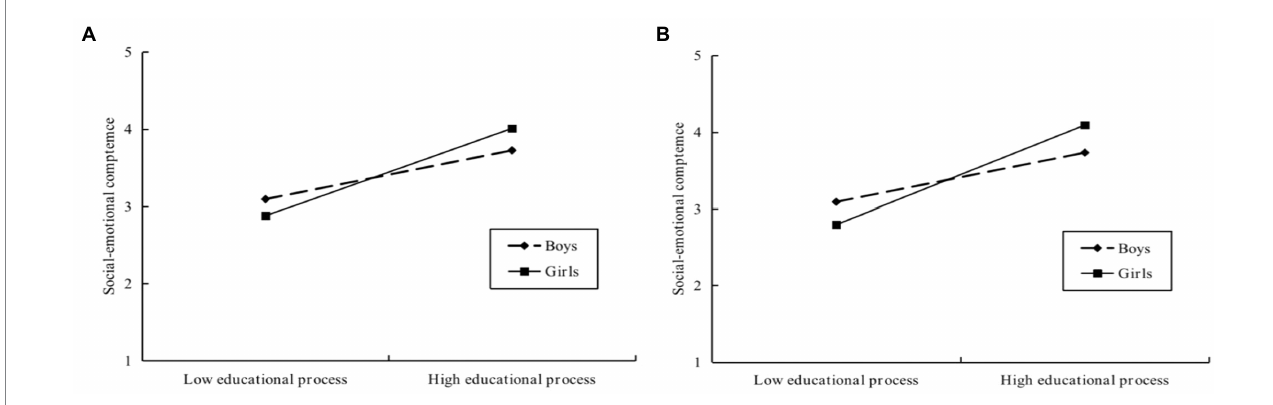
FIGURE 5 The moderating effect of gender on the relationship between educational processes and preschool children’s social–emotional competence: Simple slope, the pick-a-point approach. (A) : Simple slope for Model a, gender moderates PBI, EP and SEC. (B) : Simple slope of Model b, gender moderates SFC, EP and SEC.